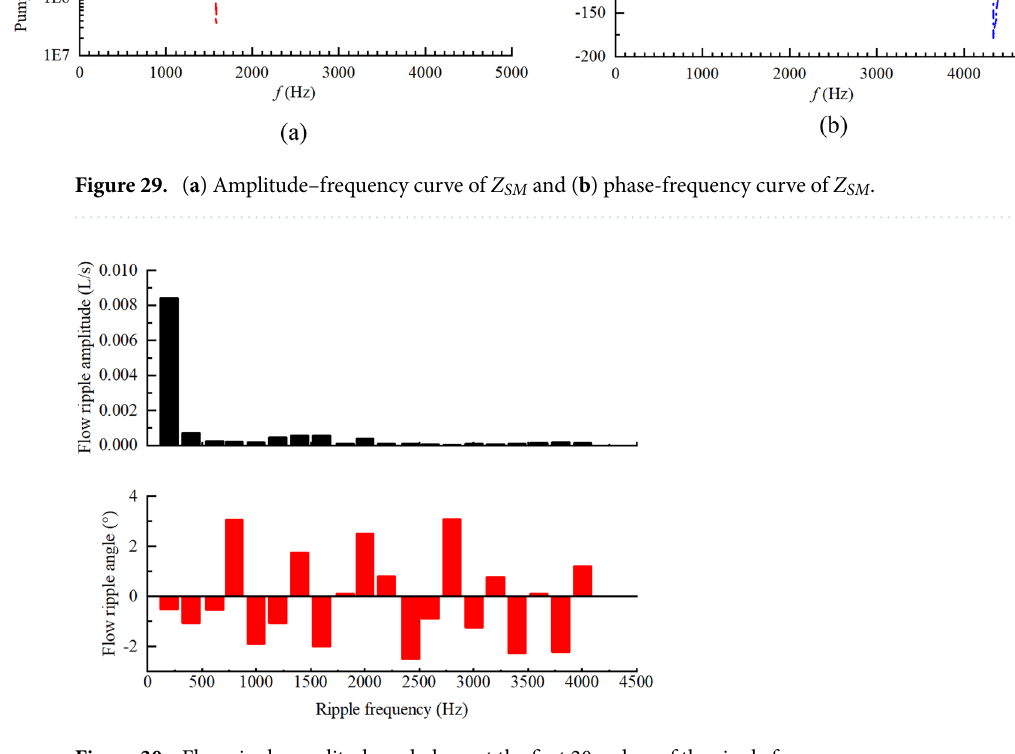
Figure 30. Flow ripple amplitude and phase at the first 20 orders of the ripple